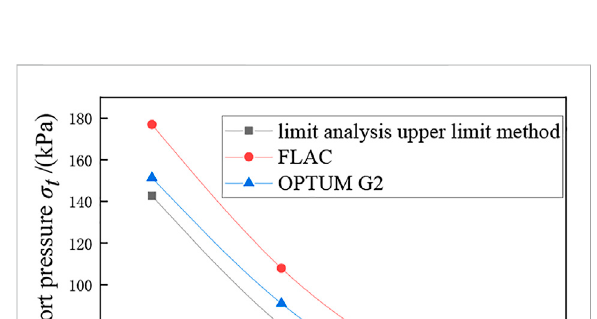
FIGURE 9 C / D = 1 fi nite element limit analysis calculation of the failure mode of the tunnel